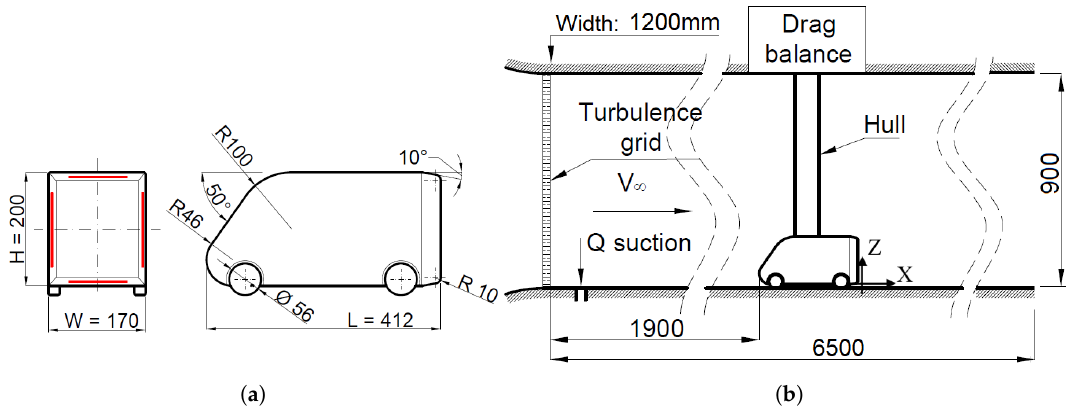
Figure 1. ( a ) Schematic representation of the model; the red continuous lines are representative of the injection slots of the active flow control system. ( b ) Schematic representation of the wind tunnel test section and indication of the reference frame. Dimensions are given in